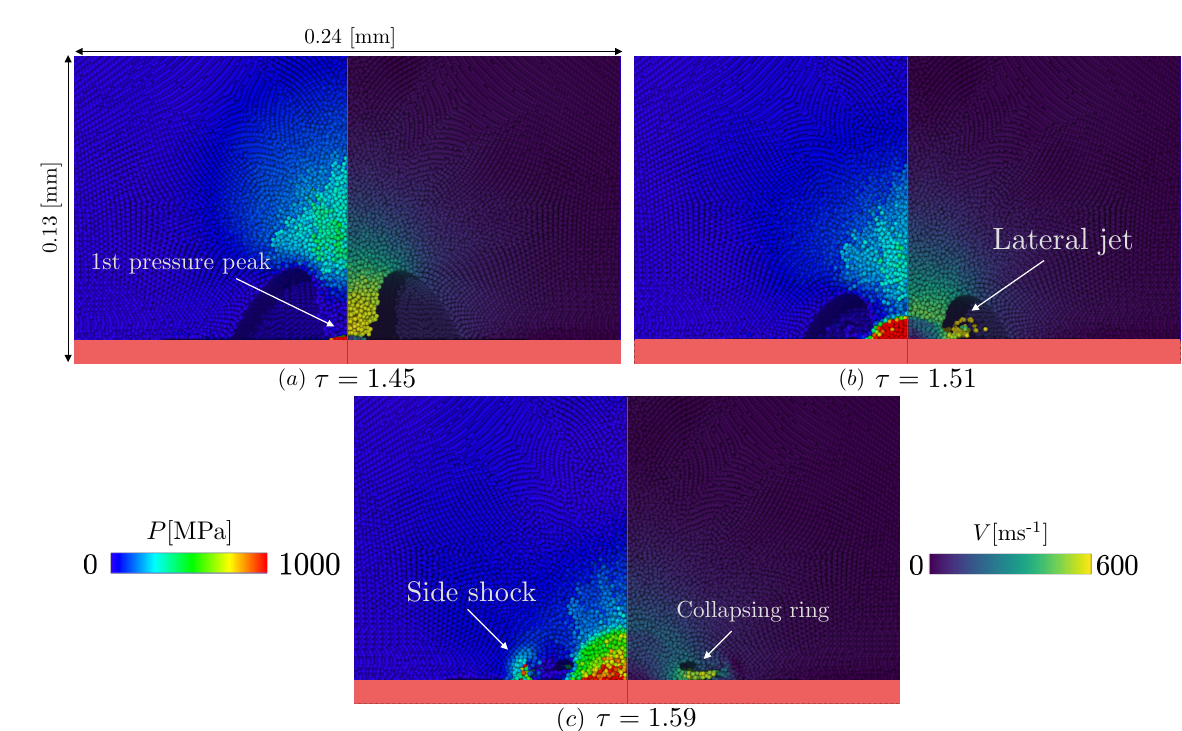
Figure 5. Pressure and velocity field in the domain represented in Figure 1 for different collapse snapshots in Region II ( dL / R 0 = 133, γ = 0.6 & P ∞ = 50 [MPa]): ( a ) The jet impacts with the surface generating a water hammer impact. ( b ) The impact splits the jet in a high-speed/low pressure circular lateral jet. ( c ) The lateral jet impacts with the cavity side generating side shocks in the liquid phase.